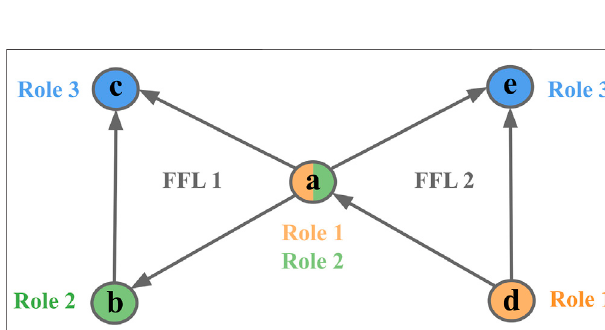
FIGURE 2 | Node participation in FFL motif. An example of 3-node motif counts given on an FFL motif. Node a plays different roles in two FFL motifs [( a c) and ( d, a, and e ) respectively]. Colors represent different